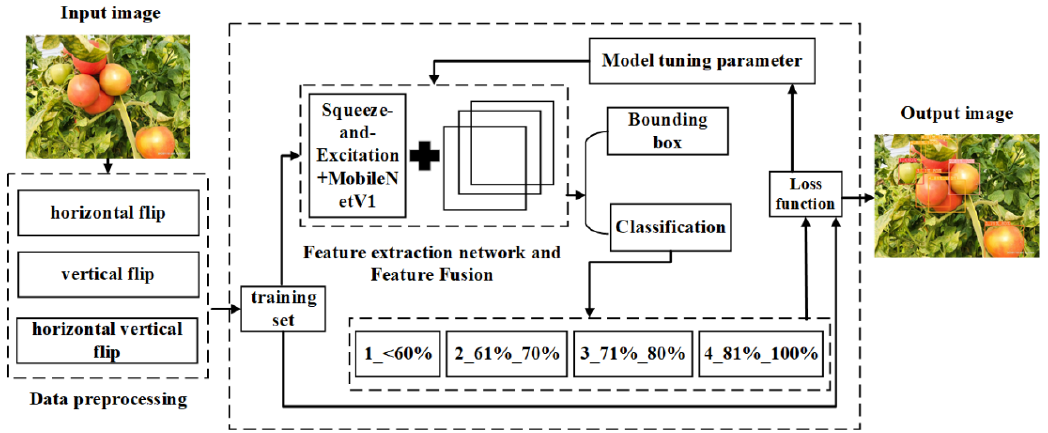
Figure 7. The construction process of tomato classification model.